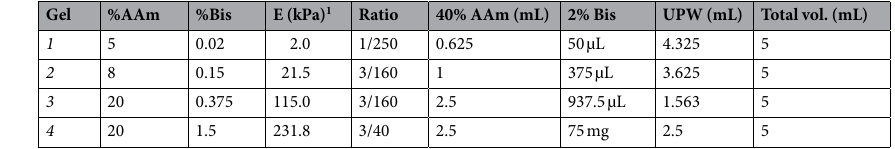
Table 1. Polyacrylamide stock solution